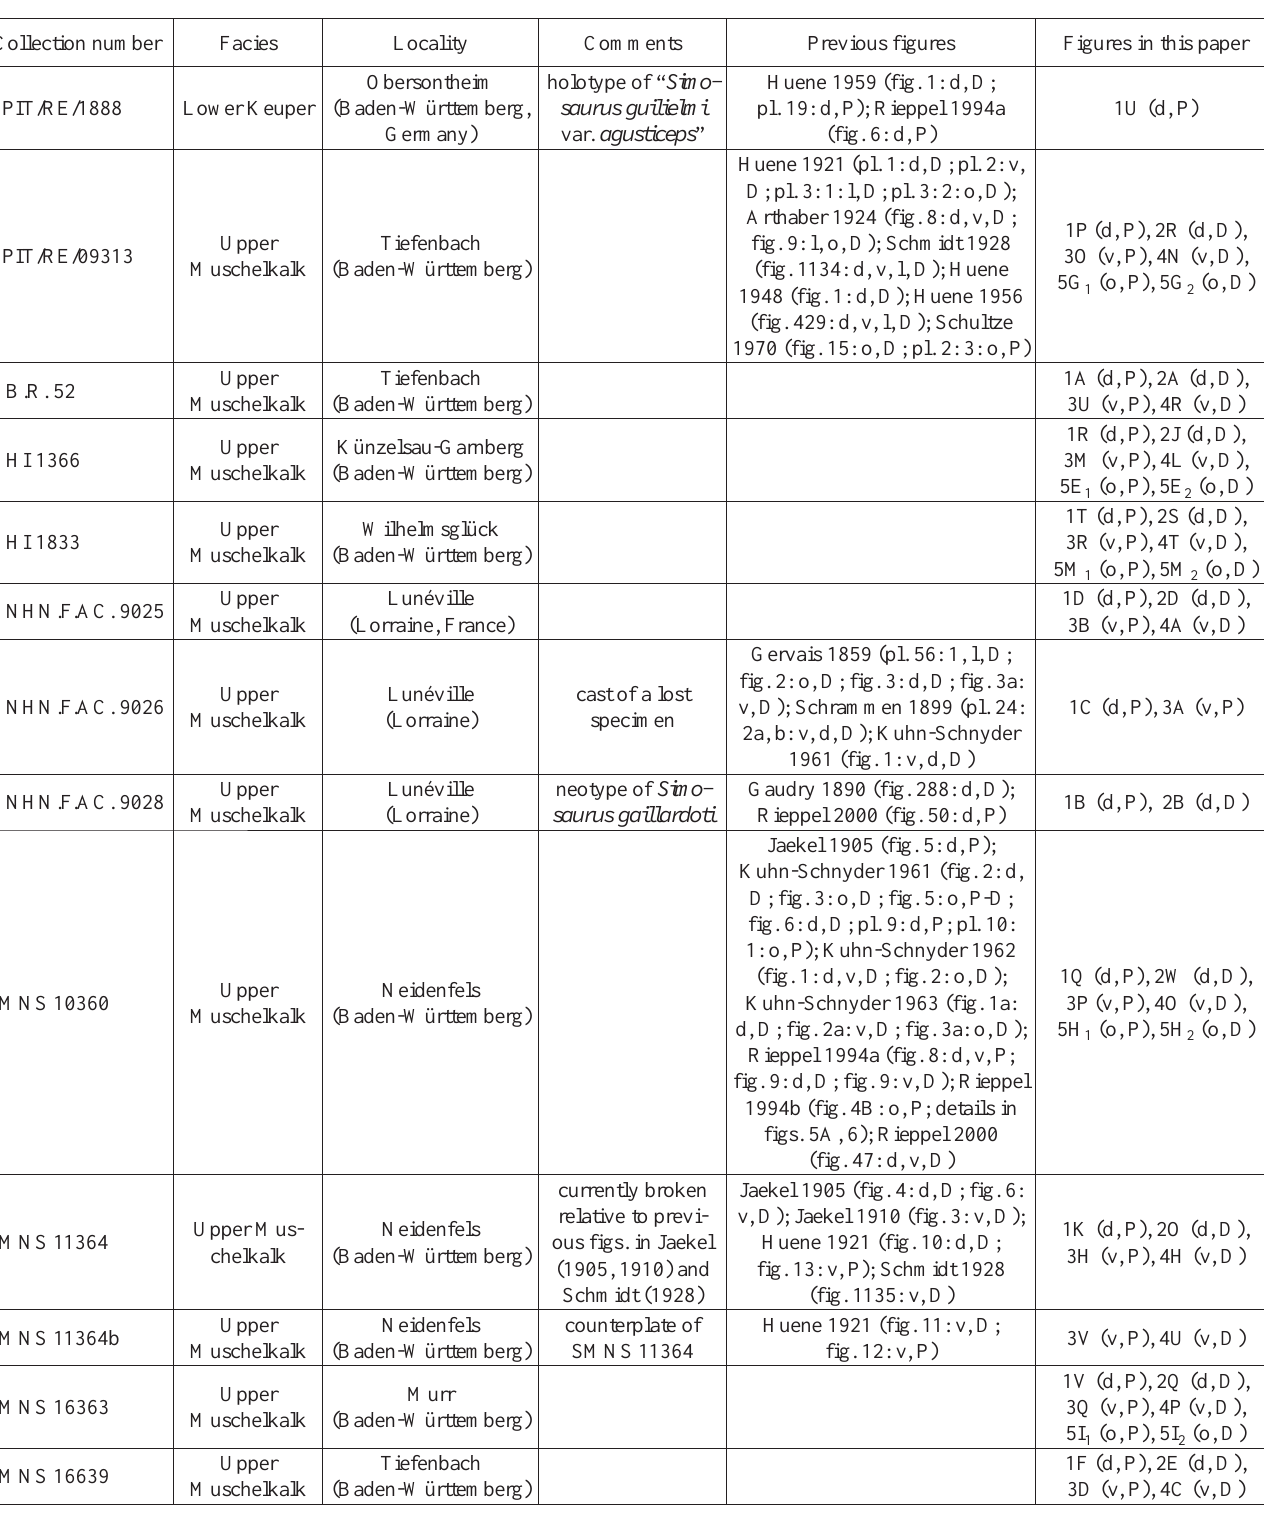
Arthaber 1924 (fig. 8: d, v, D; fig. 9: l, o, D); Schmidt 1928 (fig. 1134: d, v, l, D); Huene 1948 (fig. 1: d, D); Huene 1956 (fig. 429: d, v, l, D); Schultze 1970 (fig. 15: o, D; pl. 2: 3: o, P)